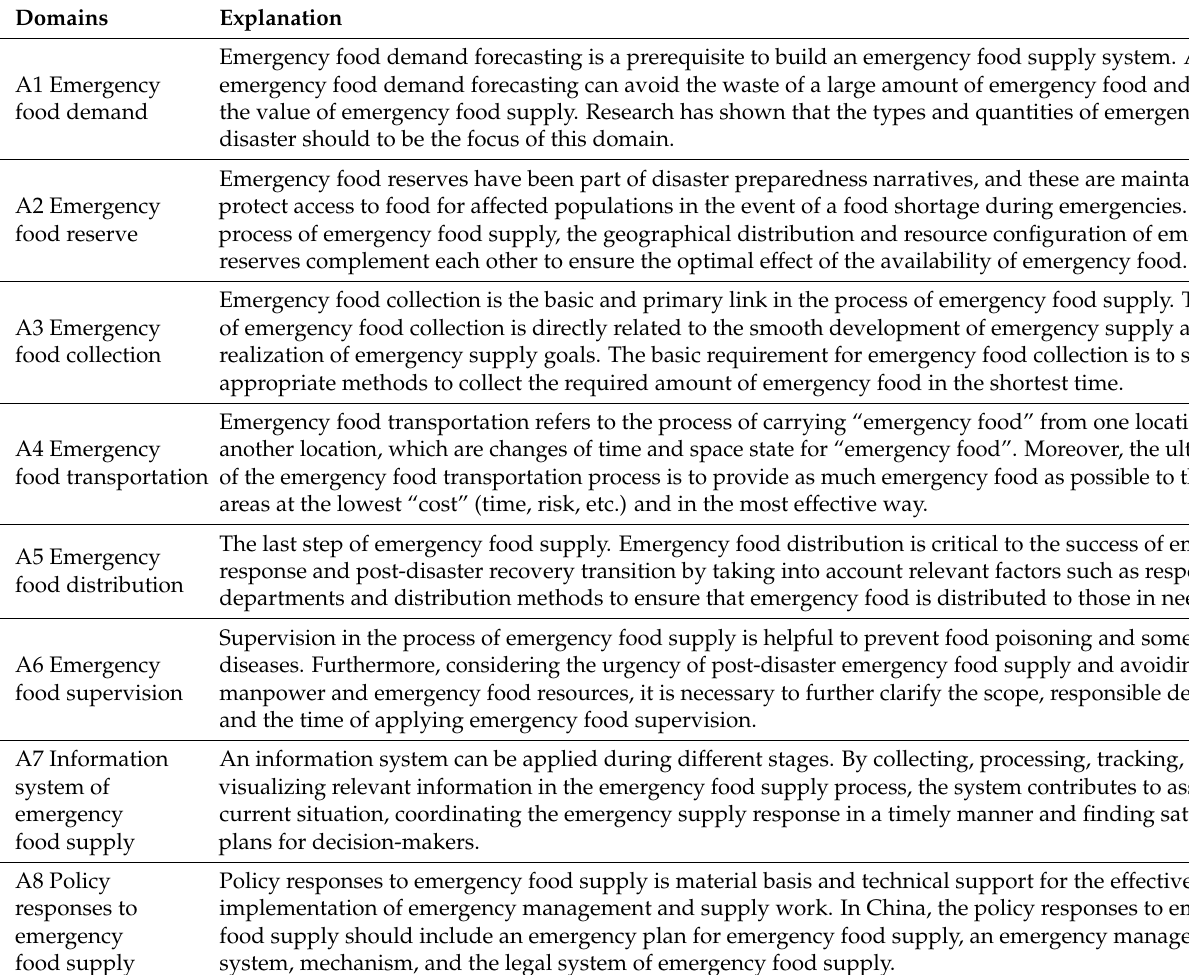
Table A2. Explanation of domains and